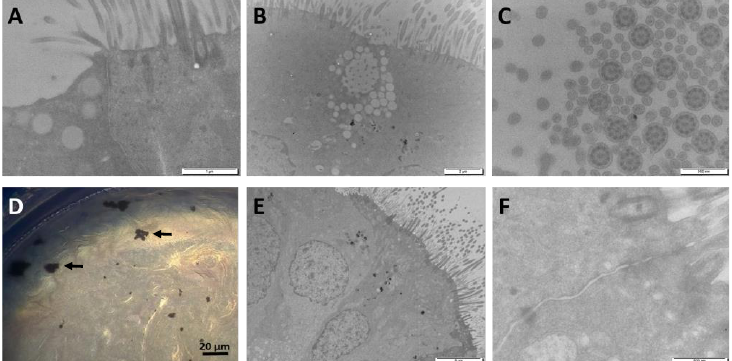
Figure 3. Optical microscopy and TEM observation of MucilAir ™ before and after exposure to milled W-NPs. The morphology of MucilAir ™ was observed before ( A – C ) and after ( D – F ) exposure to 50 µ g / cm 2 milled W-NPs. Tight junctions, ciliated cells and mucous cells, presenting several mucous vesicles, were observed ( A , B ; TEM). A cross sectional image ( C ; TEM) showed that MucilAir ™ cilia have a typical ultrastructure with axonemes, dynein arms and central tubules. At the end of the exposure ( D ; optical microscopy), small aggregates / agglomerates of W-NPs were onto the borders of the insert. At day 28 post exposure ( E , F ; TEM), the confluency of the tissue is maintained, as well as tight junctions. Size bars: A = 1 µ m; B = 2 µ m; C = 500 nm; D = 20 µ m; E = 5 µ m; E = 5 µ m, F = 500